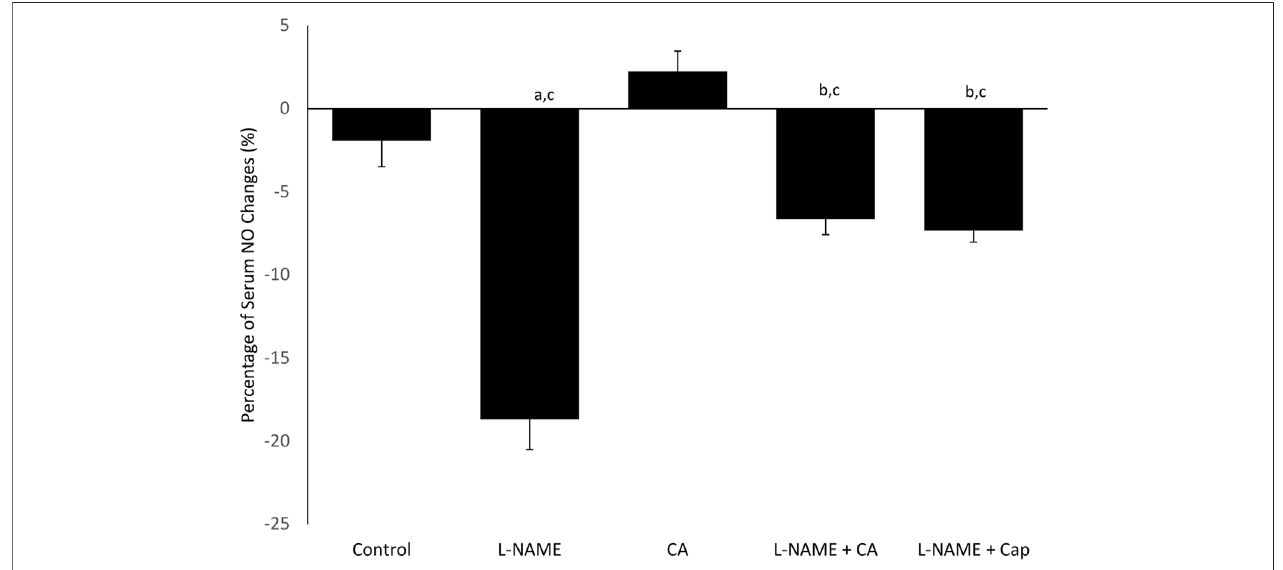
FIGURE 3 | Percentage of plasma nitric oxide (NO) change in rats given C. asiatica extract (500 mg/kg orally) and captopril (5 mg/kg orally) together with L -NAME (40 mg/kg orally) for 8 weeks. Bars represent mean ± SEM ( n (cid:1) 6). a versus control ( p < 0.05), b versus L -NAME ( p < 0.05), c versus C. asiatica ( p < 0.05).